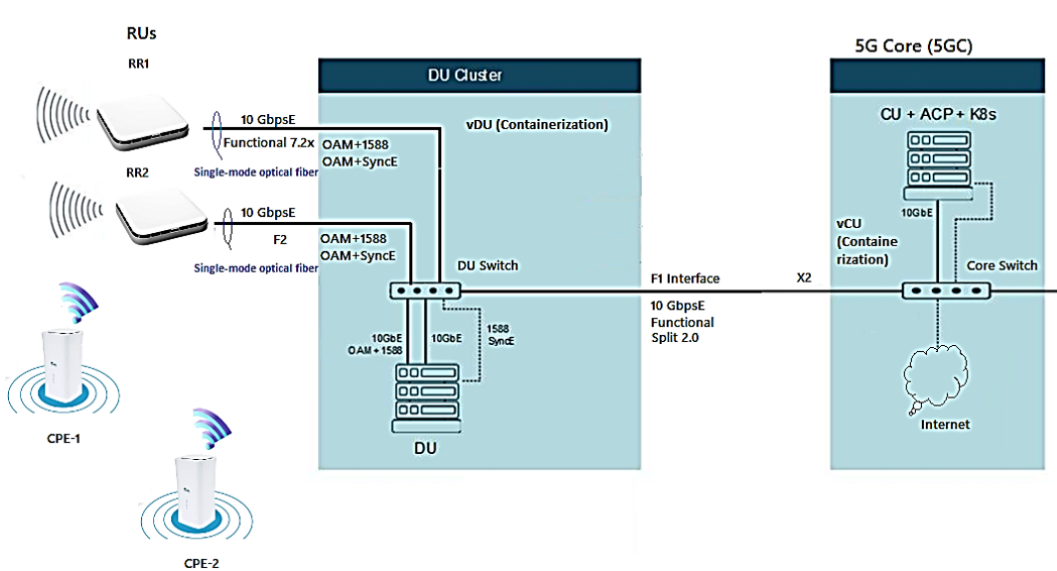
Figure 9. Simplified architecture of RUs+CPEs+DU+5GC. Based on